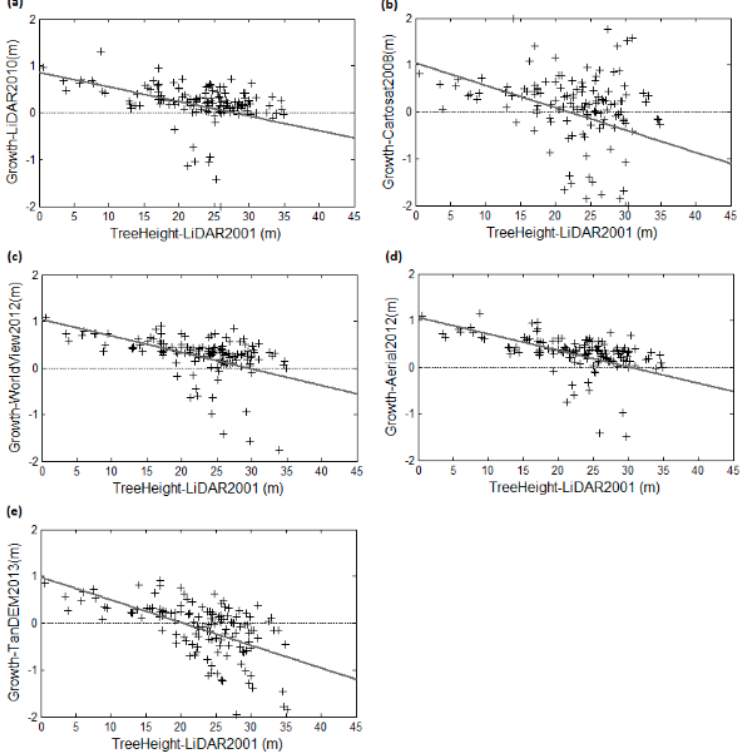
Figure 12. Relationship between tree heights and PAIs for: LiDAR2010 ( a ); Cartosat2008 ( b ); WorldView2012 ( c ); Aerial2012 ( d ); and TanDEM-X2013 ( e ) ( n =1 37; x -axis is the maximum tree height measured by LiDAR2001 in each inventory plot, while the y -axis represents the derived PAIs.).